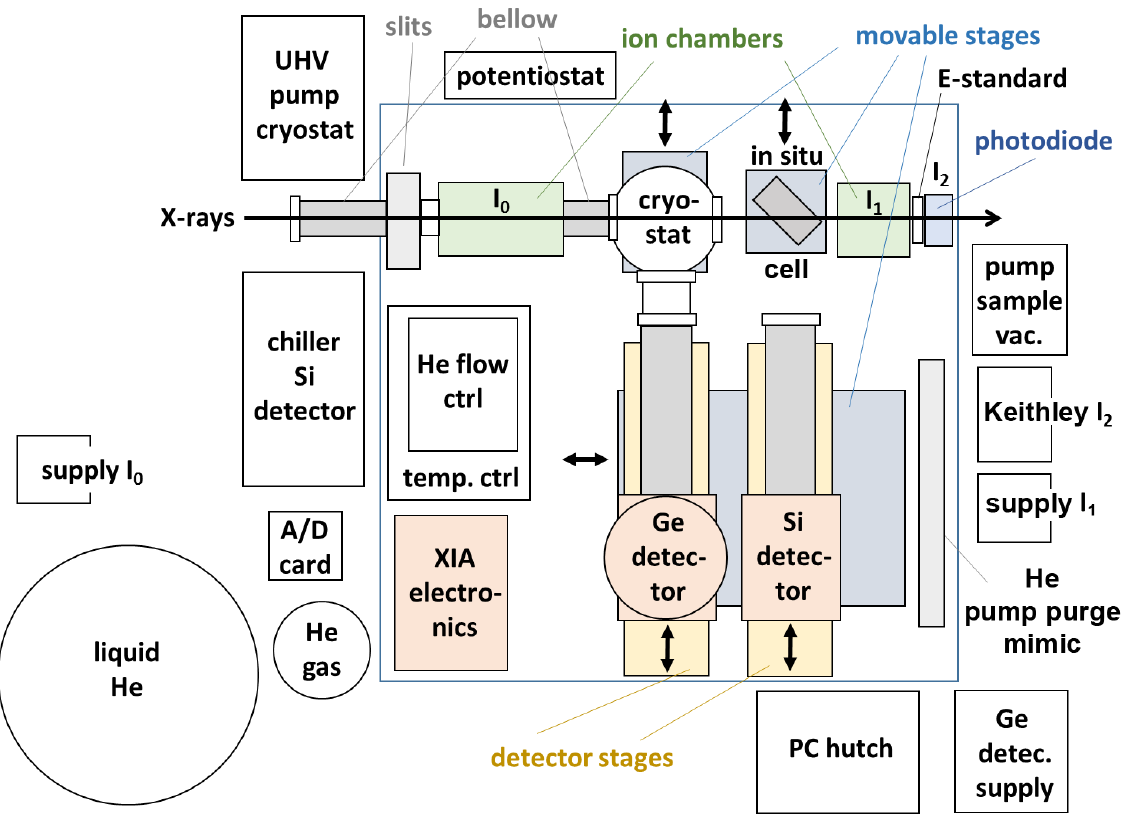
Figure 1: Scheme of the experimental setup for XAS at KMC-3 (CryoEXAFS) with cryogenic or in- situ (operando) ambient-temperature sample condition. Two energy-resolving 13-element fluorescence detectors (Ge and Si) can be used alternatively and facilitate switching between both types of experiments without rearrangements of the experimental